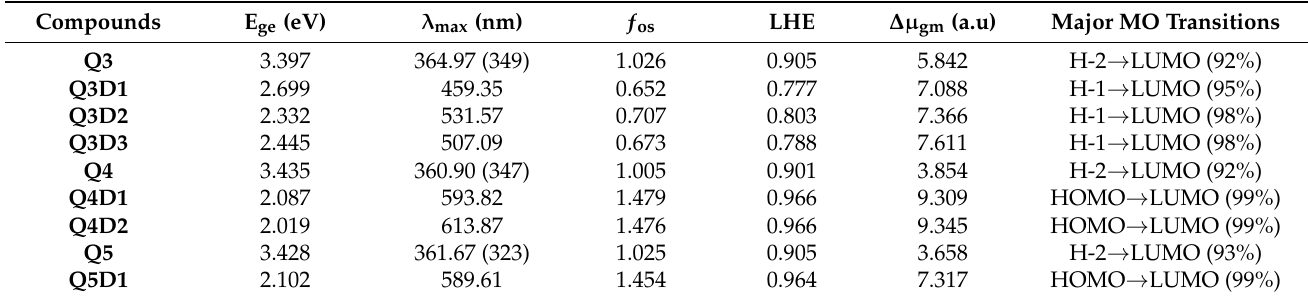
Table 5. Computed transition energy (eV), maximum absorption wavelengths ( λ max /nm), oscillator strengths (f os ), light- harvesting efficiency (LHE), transition moment (M gm